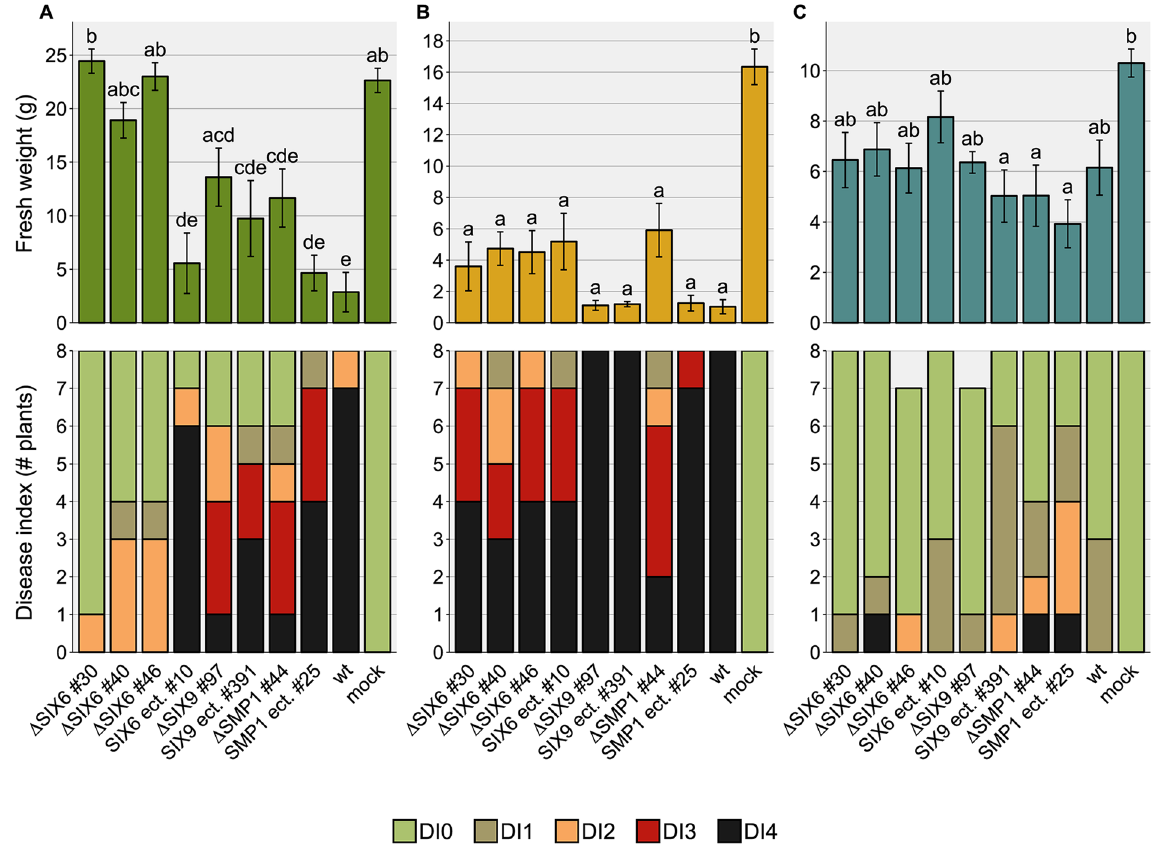
Figure 4. Three independent SIX6 deletion strains cause less symptom development in cucumber. Fresh weight ( ± S.E.) and disease index (DI) of ( A ) cucumber, ( B ) melon and ( C ) watermelon plants were scored 14 days post inoculation. An ANOVA followed by a Tukey HSD test (p < 0.05) was performed to determine significance of the differences in the fresh weight measurements (significance categories shown with letters above the bars). Under the tested conditions (10 6 spores/ml, 25 °C), three independent SIX6 deletion strains caused reduced symptoms in cucumber compared to wildtype (wt) and an ectopic transformant ( SIX6 ect. #10). Knockout of the two other candidate virulence genes SIX9 and SMP1 did not have a significant effect on virulence. Under these conditions (25 °C), Forc causes only mild symptoms on